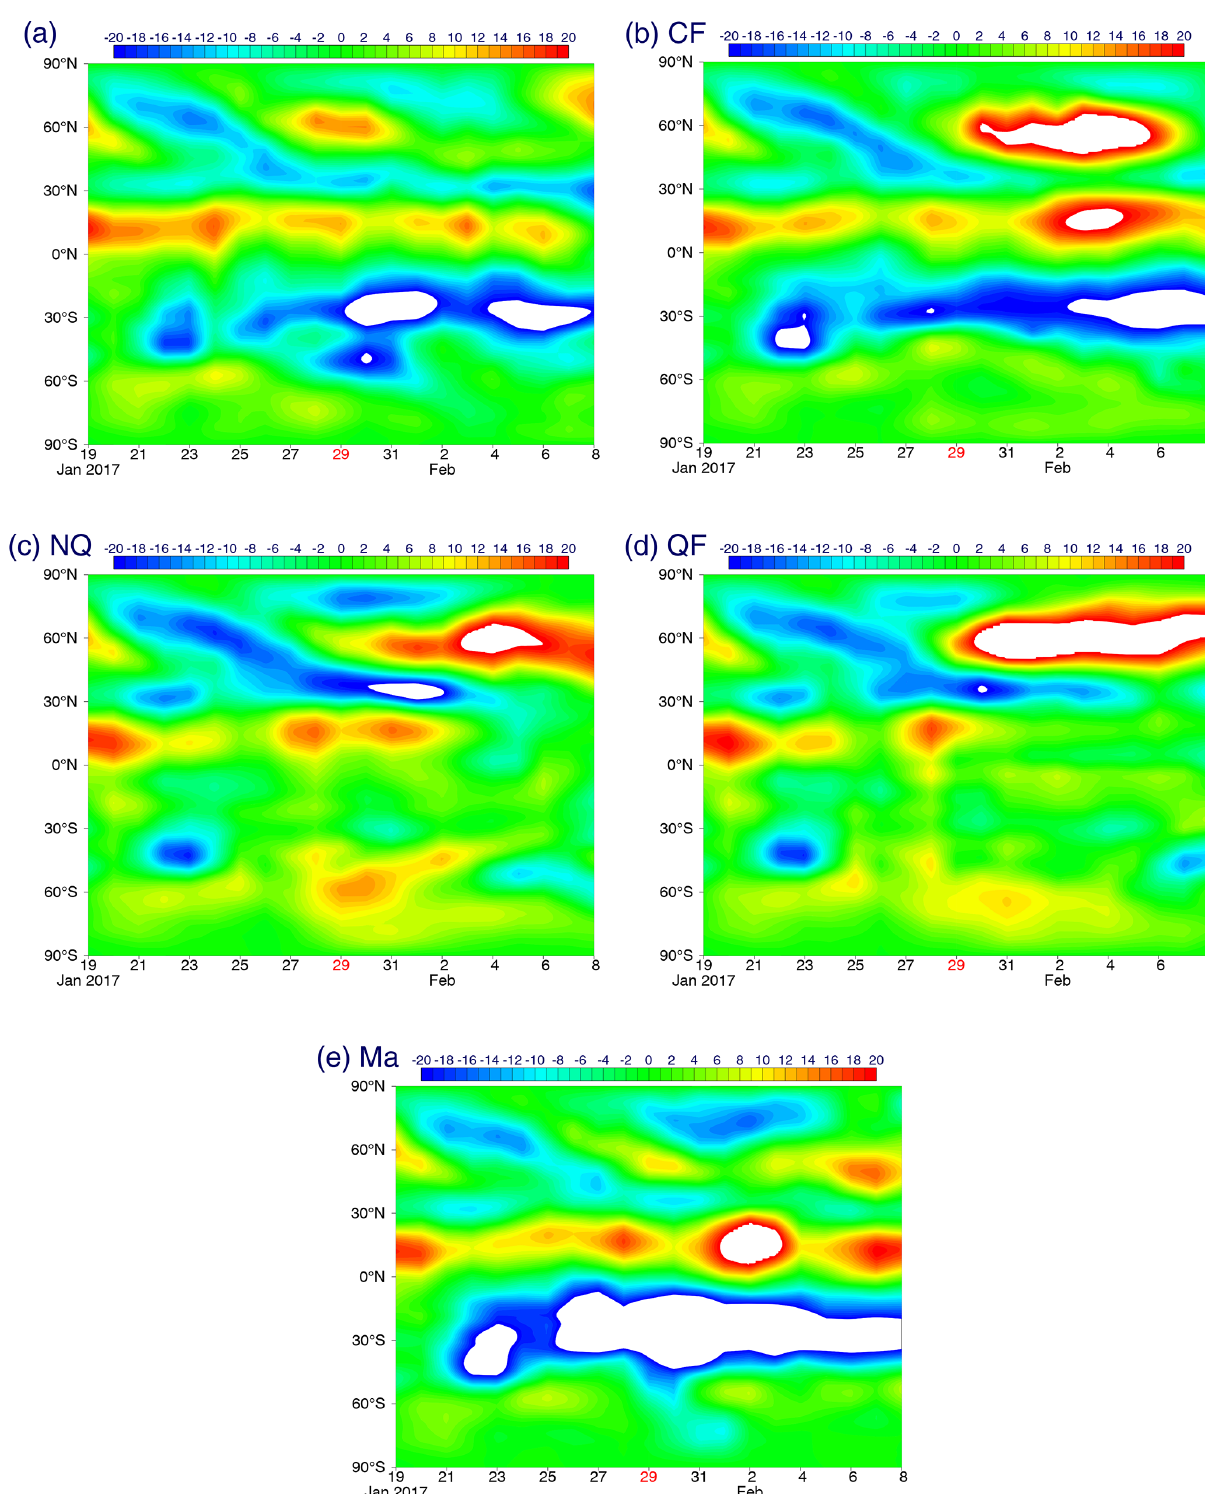
Figure 9. Time–latitude sections of the 150hPa stream function averaged over 20–60 ◦ E: (a) the analysis for the standard 20d forecast period, and the standard 20d forecasts with (b) CF, (c) NQ, (d) QF and (e) Ma.